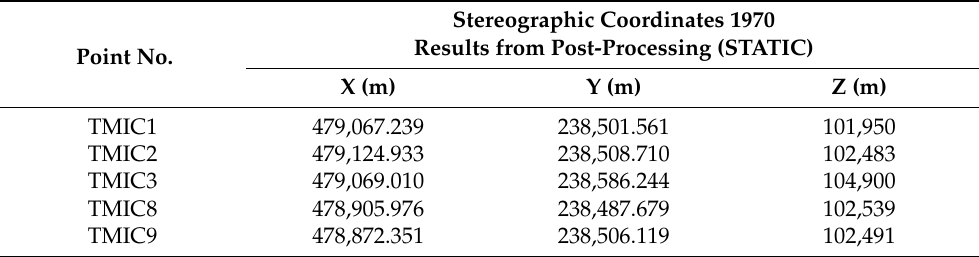
Table 11. 1970 Stereographic coordinates obtained by STATIC measurements after post-processing.